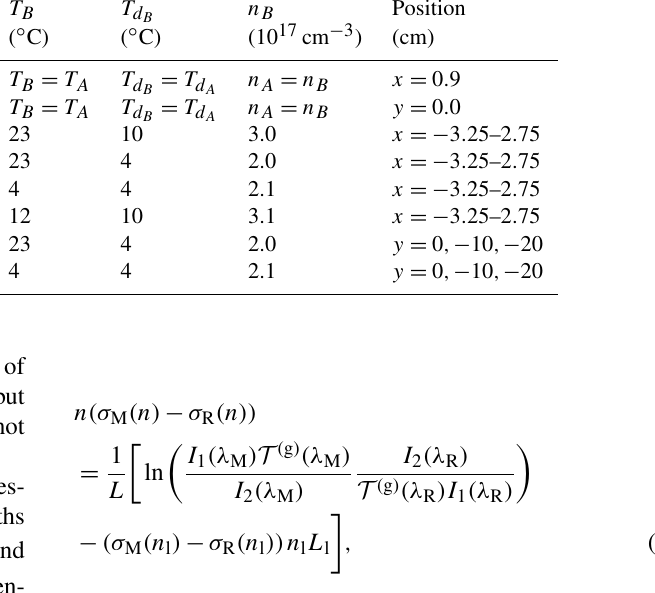
Table 1. List of experiments together with the corresponding wind tunnel and FIRH settings.